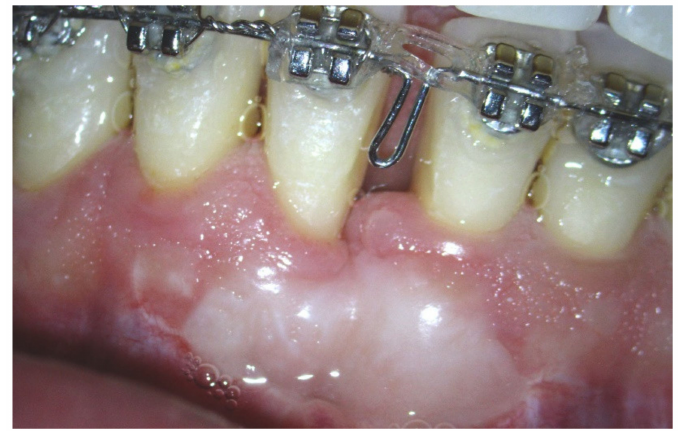
Figure 3. Clinical situation at T2 before starting completion of orthodontic treatment.